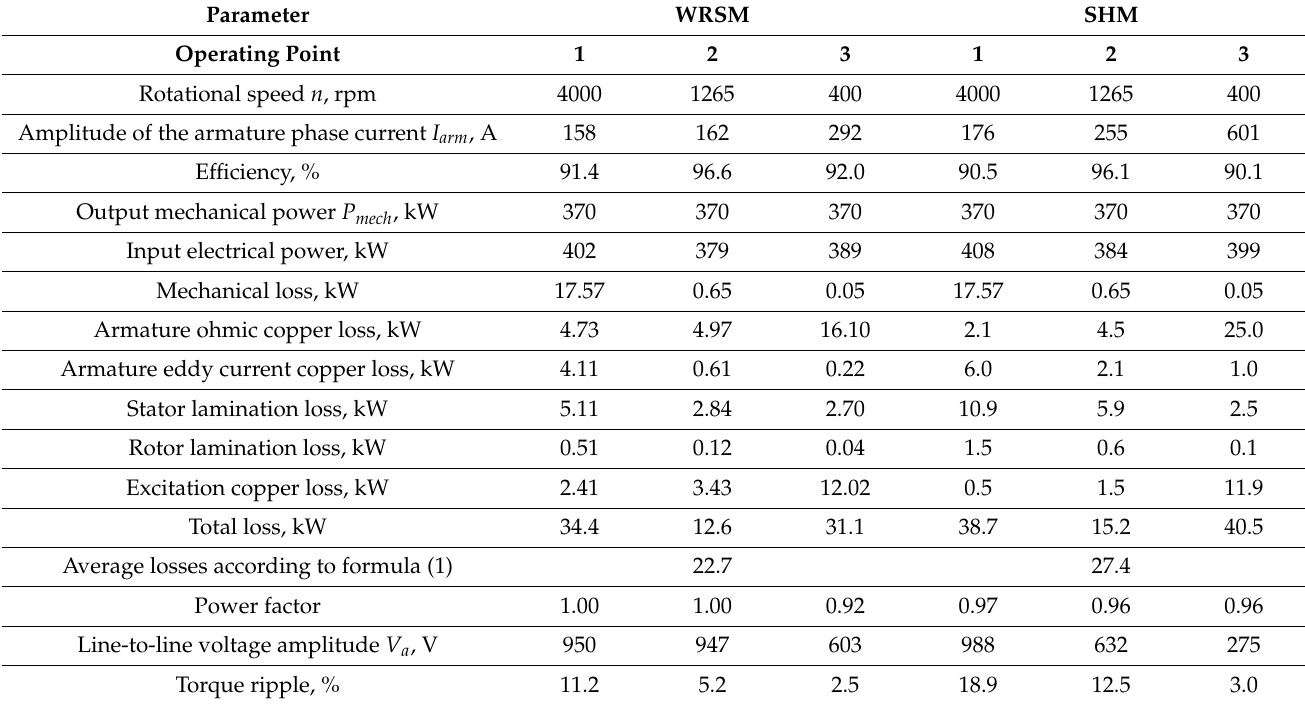
Table 5. Comparison of the characteristics of the optimized WRSM and SHM.